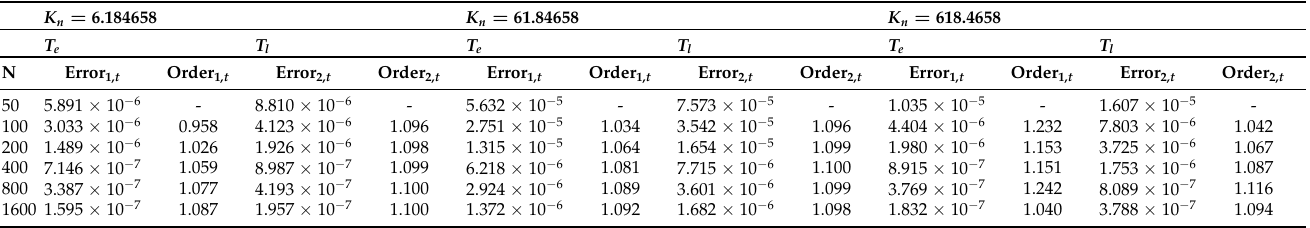
Table 8. Temporal convergence rate when M = 500 and ( α , β ) = ( 0.2,0.9 ) for Example 2.